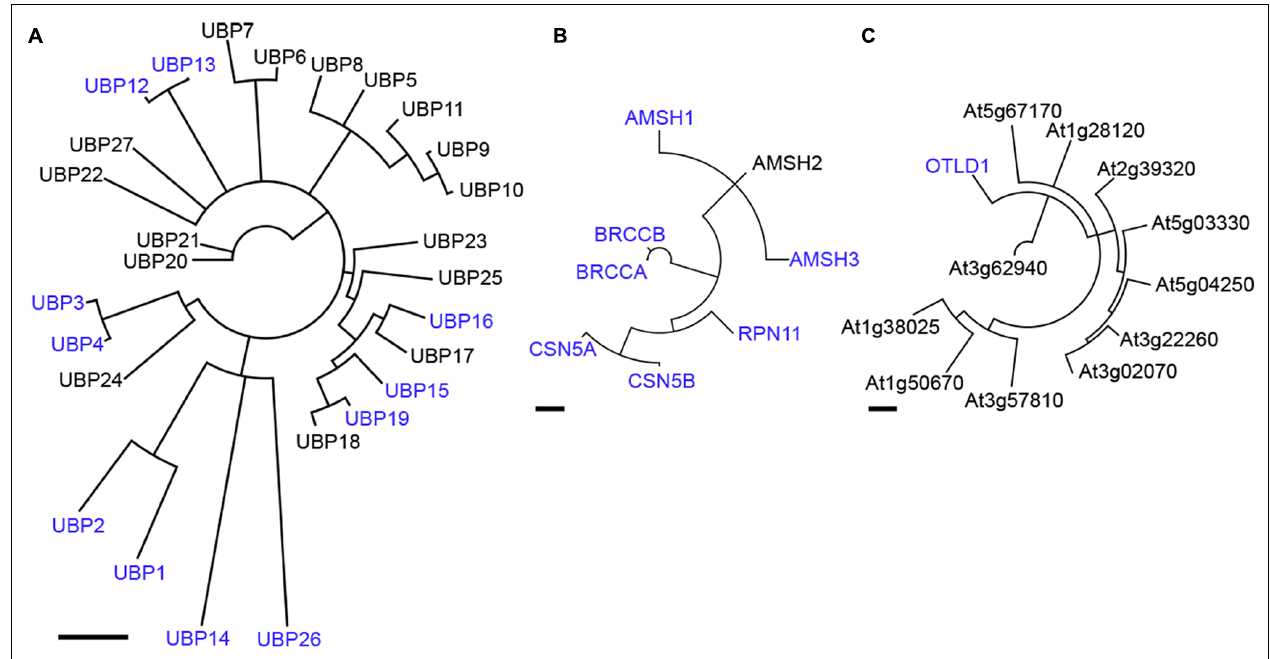
FIGURE 2 | Phylogenetic analyses of Arabidopsis UBP-, JAMM-, and OTU-domain proteinases. A Neighbor-Joining consensus tree based on amino acid sequences surrounding the catalytic domain for Arabidopsis UBP- (A) , JAMM- (B) and OTU- (C) domain proteins is